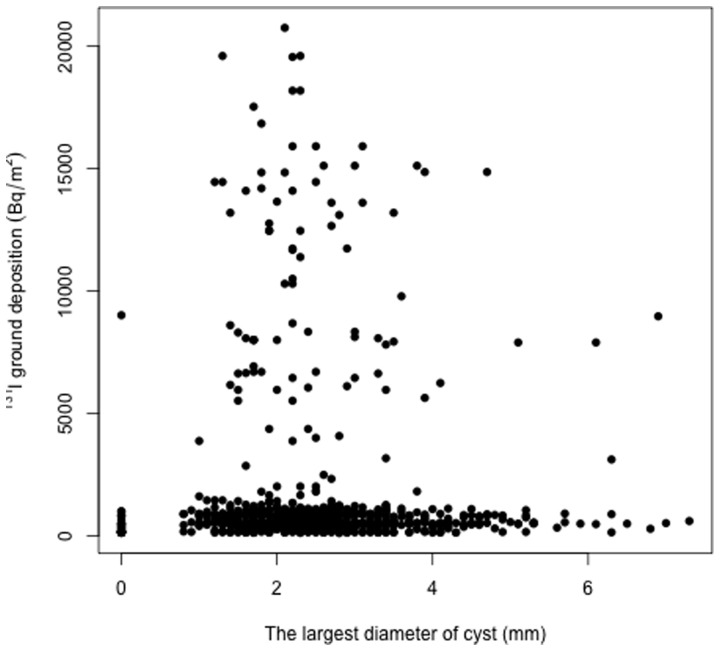
Scatter plot of the largest diameter of cyst vs. the 131I ground deposition in the 811 subjects who had cysts in the thyroid.Regression analysis revealed that there was no significant correlation between the two parameters.